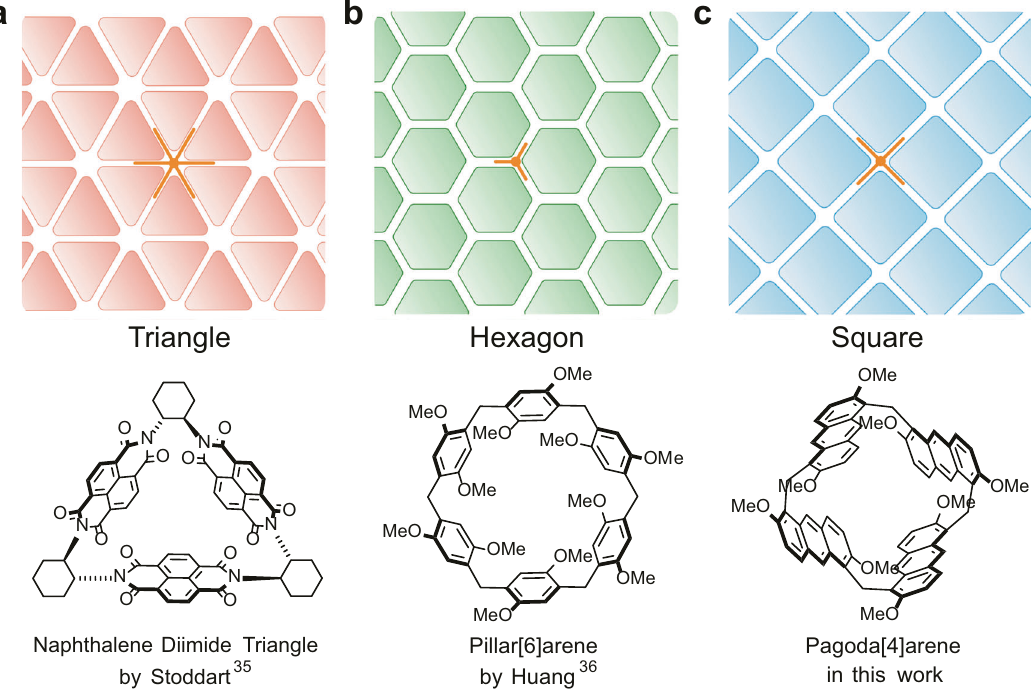
Fig. 1 Three regular supramolecular tessellation building blocks. a Naphthalene diimide triangle. b Pillar[6]arene hexagon. c Pagoda[4]arene